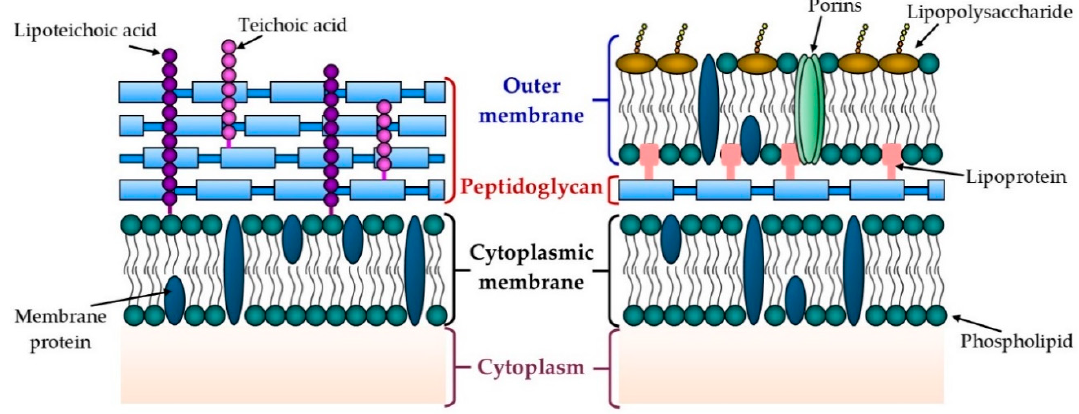
Figure 4. Schematic representation of Gram-positive ( left ) and Gram-negative ( right ) bacteria.